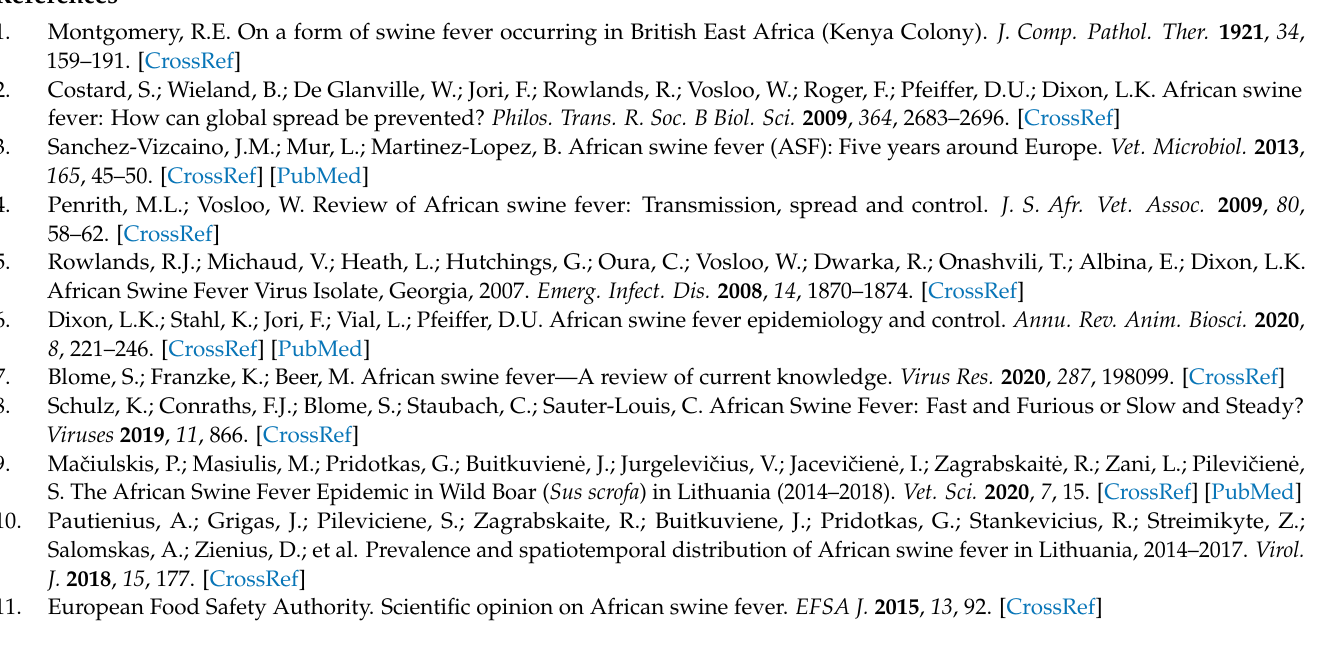
Table S7: Median of the estimated number of wild boar/km 2 based on hunting bag data per year and the results of the Mann–Whitney U test. Significant differences between the hunting